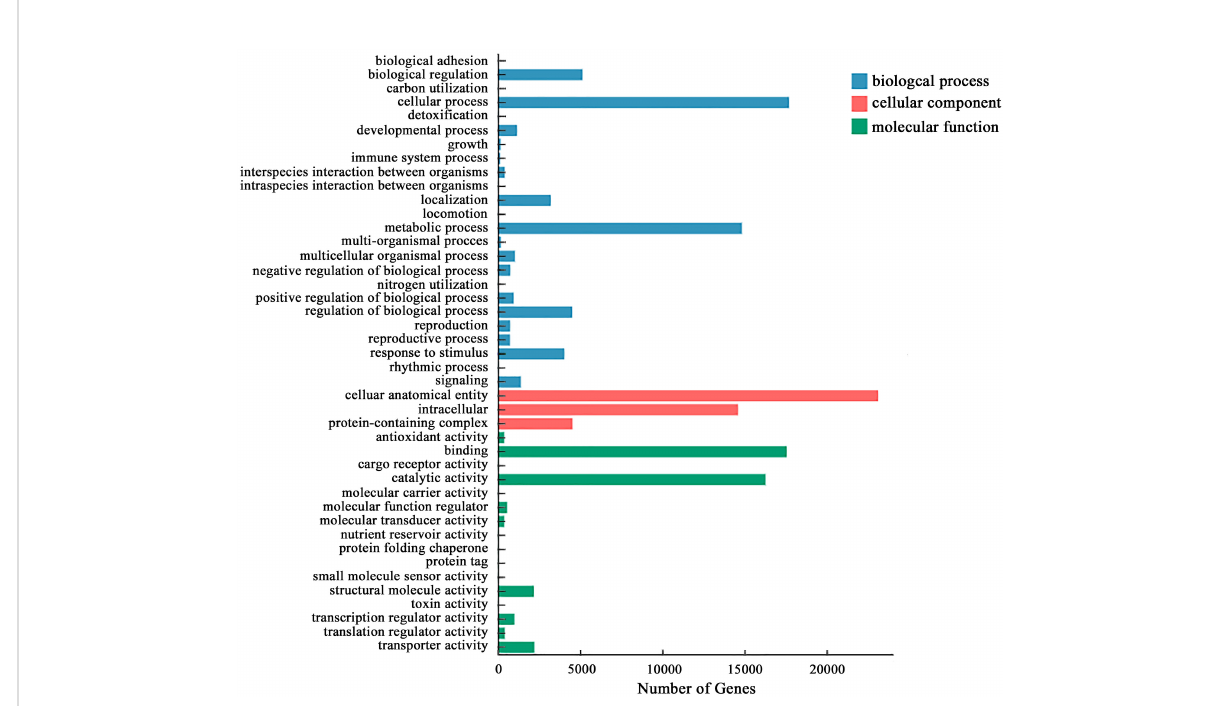
FIGURE 2 Gene ontology (GO) enrichment classi fi cation map of differentially expressed genes in the roots of P. crinitum under Pb